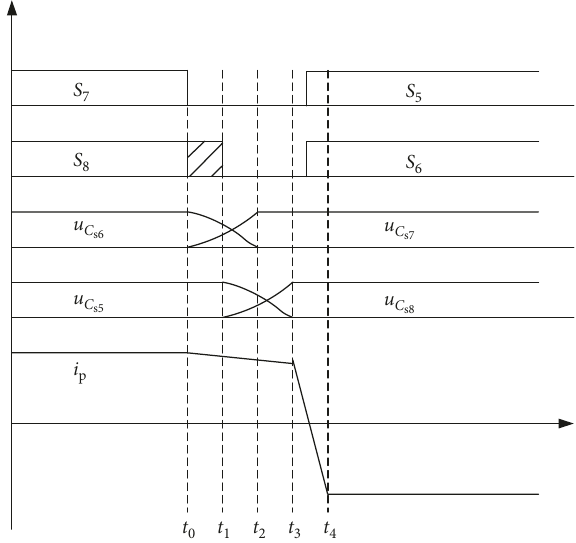
Figure 16: Main waveforms when S